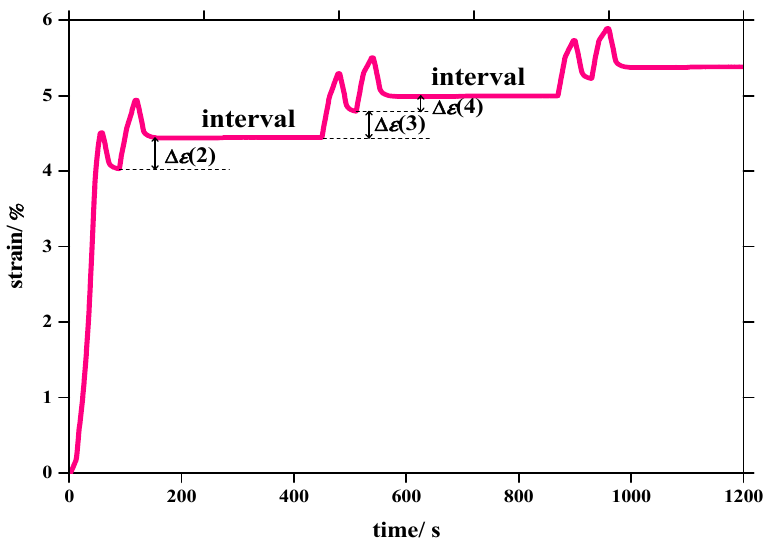
Figure 5. Fatigue strain path as a function of time interval.